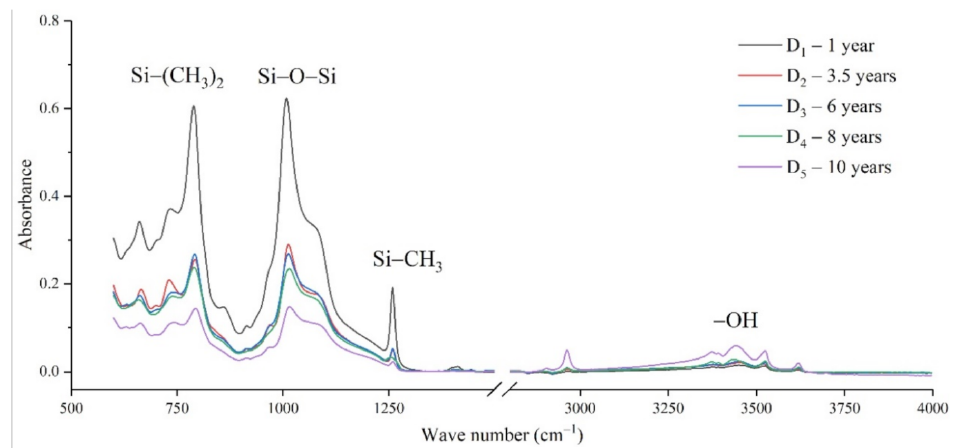
Figure 6. FTIR results of samples from manufacturer